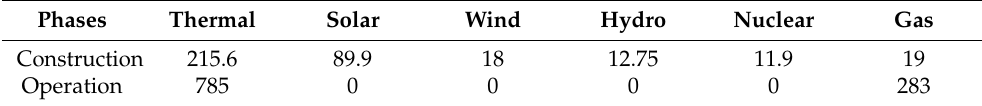
Table 1. Carbon emission parameters of energy sources in the test system (g/kWh).